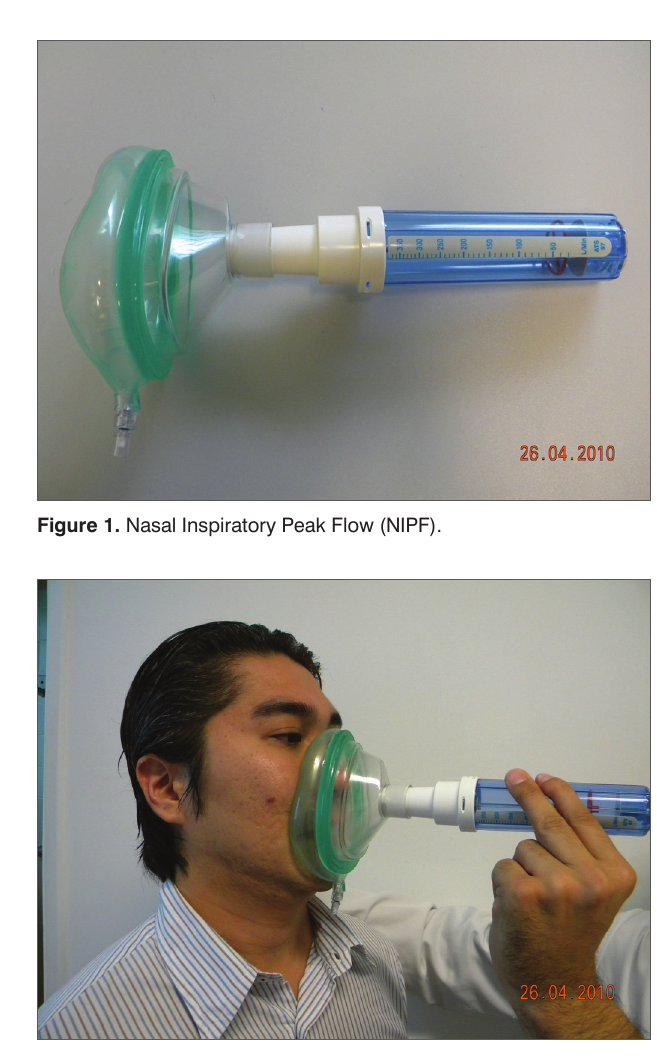
Figure 2. NIPF application.